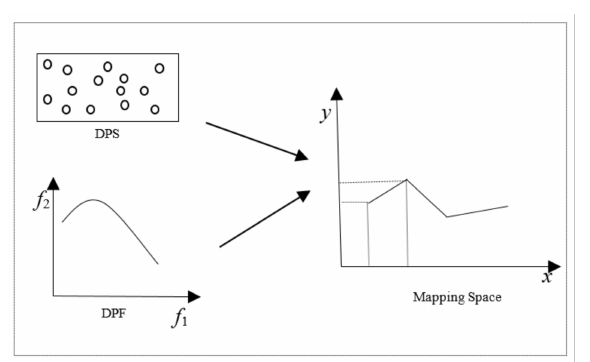
Figure 1. The mapping relation of the proposed